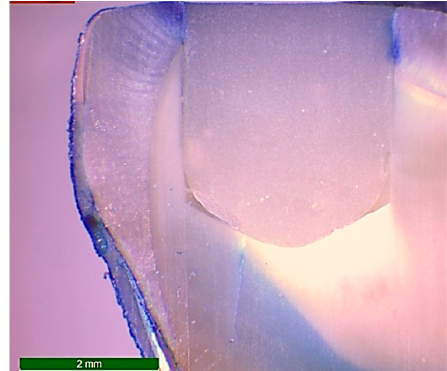
Figure 3. Microphotograph at 15X magnification of a longitudinal section of a restored standardized cavity in a sound molar after 5000 cycles of thermo-cycling and immersion in freshly prepared 1.0% methylene blue dye for 24 h in order to examine the marginal leakage by evaluation of the grade of dye penetration.